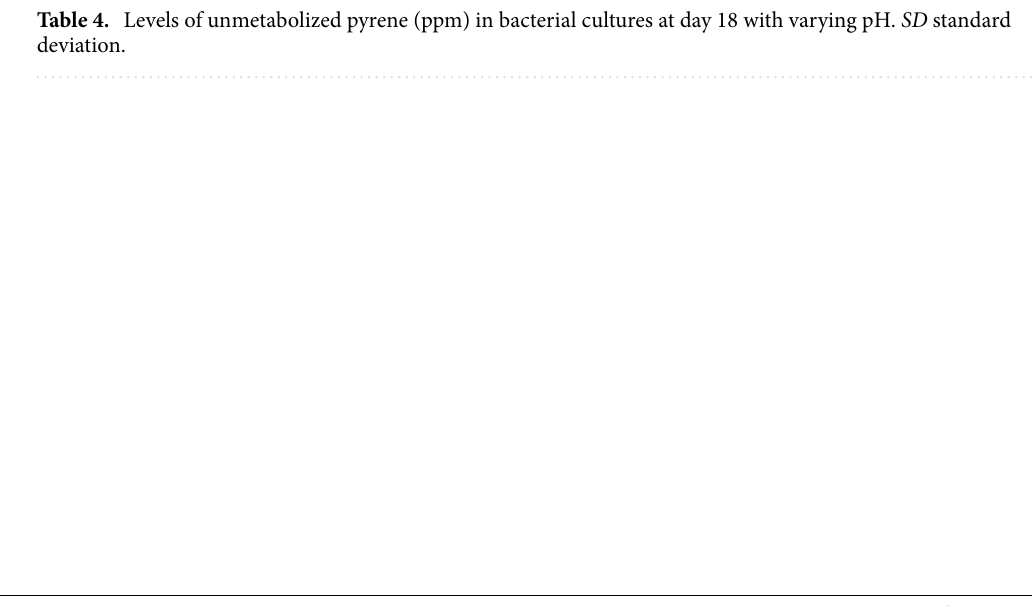
Table 4. Levels of unmetabolized pyrene (ppm) in bacterial cultures at day 18 with varying pH. SD standard deviation.